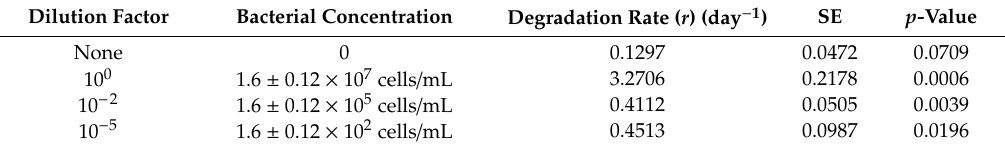
Table 3. Degradation rates of exDNA under di ff erent bacterial treatments at 35 ◦ C during incubation for 4 days. Three serial dilutions of 10 0 , 10 − 2 , 10 − 5 fold were made from the prepared bacterial solution. Average bacterial abundance in solution before dilution was 1.6 ± 0.12 × 10 7 cells / mL. Degradation rates were estimated by fitting the number of copies of each set of DNA to an exponential decay curve. SE: standard error.